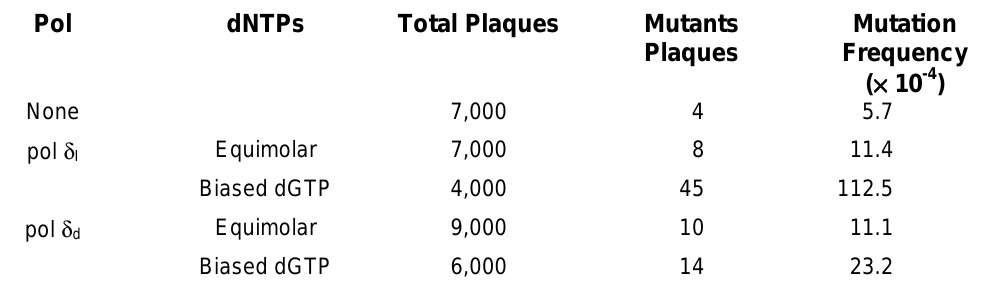
and pol δδδδ in a Forward Mutation Assay b i d